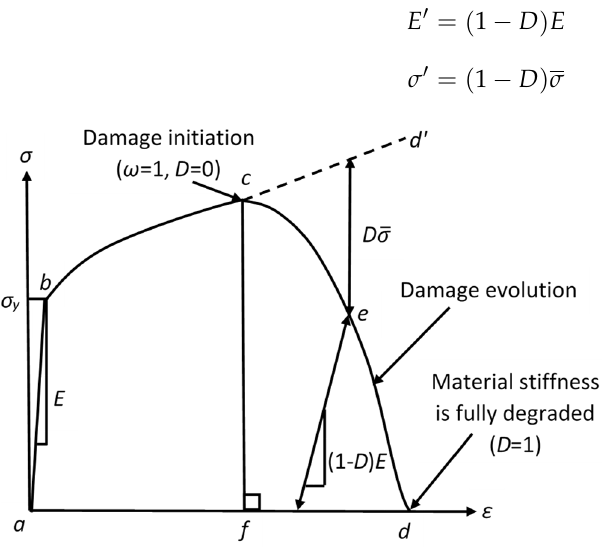
Figure 1. Typical uniaxial engineering stress–strain response of a ductile material.